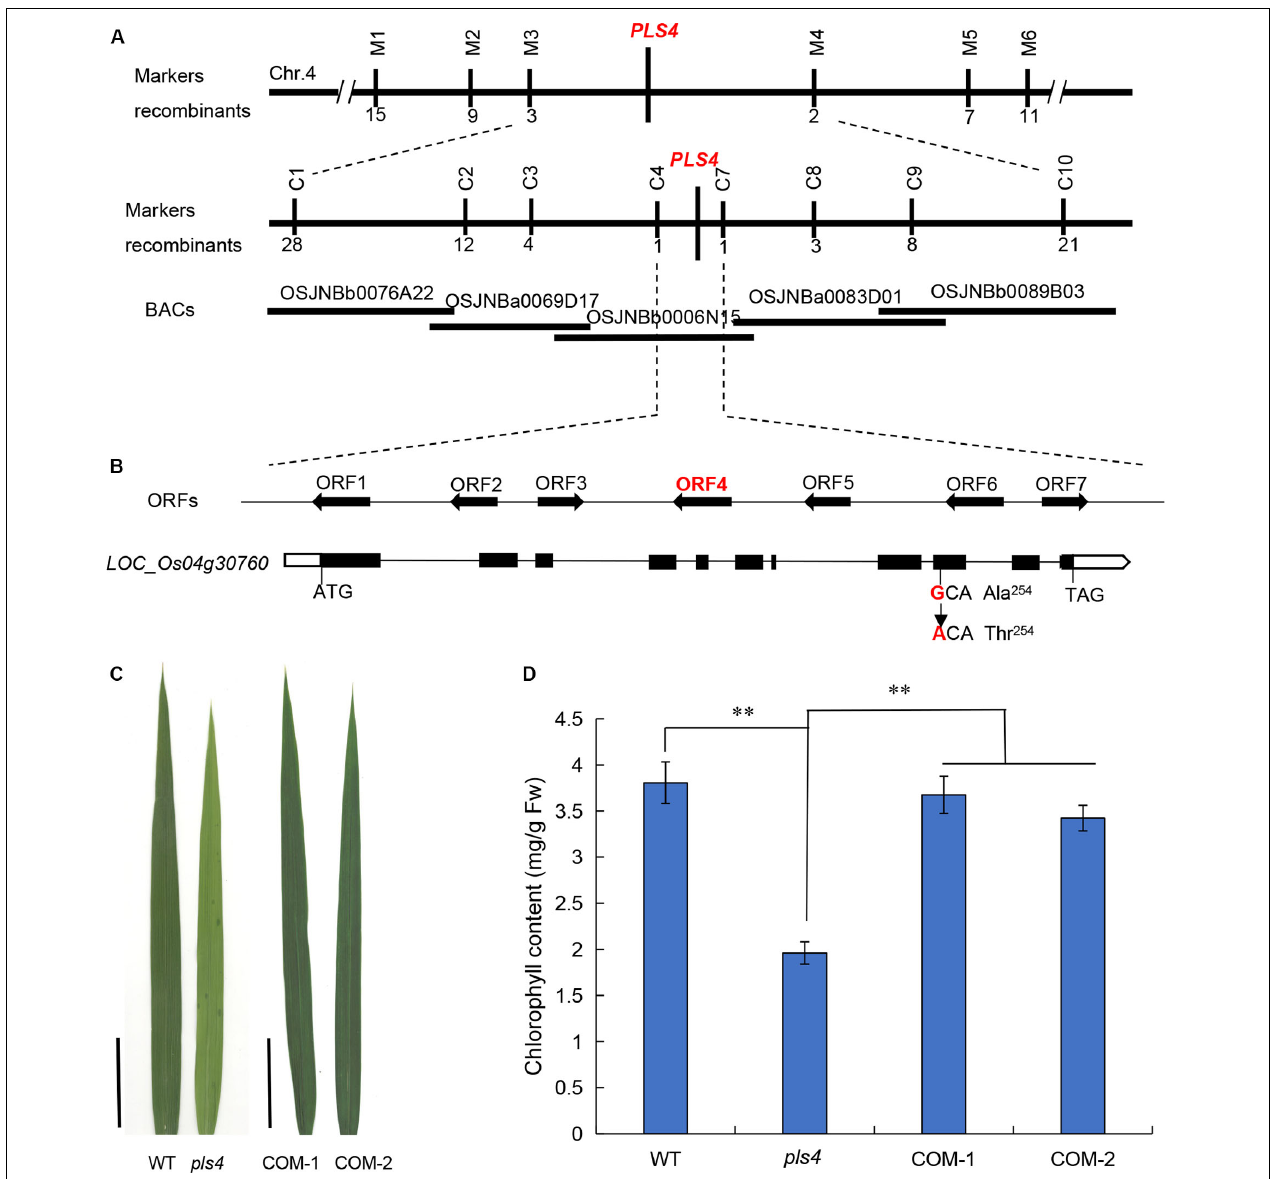
FIGURE 2 | Map-based cloning of the OsPLS4 gene. (A) Fine mapping of PLS4 further localized the mutation to a 52-kb genomic region between C4 and C7 on chromosome 4. The number of recombination events between marker and pls4 phenotype. The target region contains 7 candidate ORFs. (B) Schematic of PLS4. The black rectangles represent exons, and the position of the SNP is indicated in the ninth exon of LOC_Os04g30760 ; the SNP resulted in the mutation of the encoded protein at position 254 from alanine (Ala) to threonine (Thr). (C) The phenotype of the flag leaves in the transplanted lines, COM-1,-2: two independent complementation plants; Bars = 5 cm. (D) The flag leaf Chl content of the WT, pls4 and two COM independent lines at the heading stage. The data presented are the means ± SDs of three biological replicates. ** P < 0.01 (Student’s t